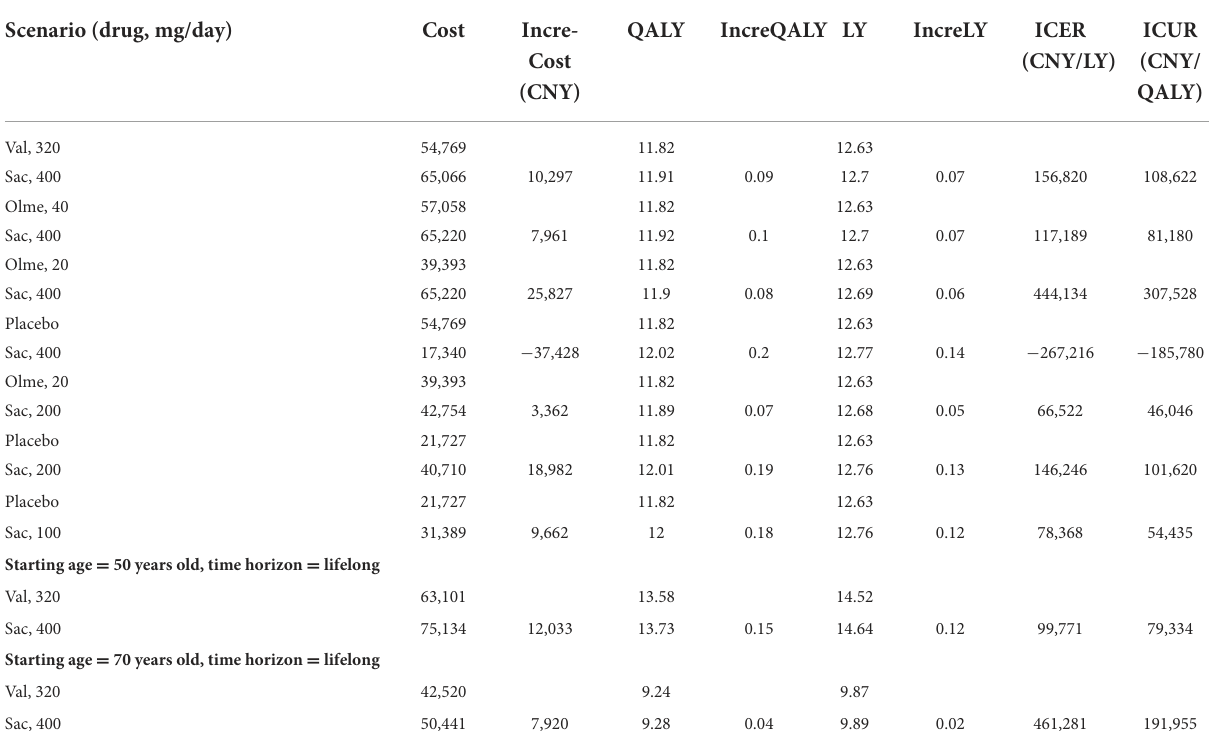
TABLE 4 Base case analysis and scenario